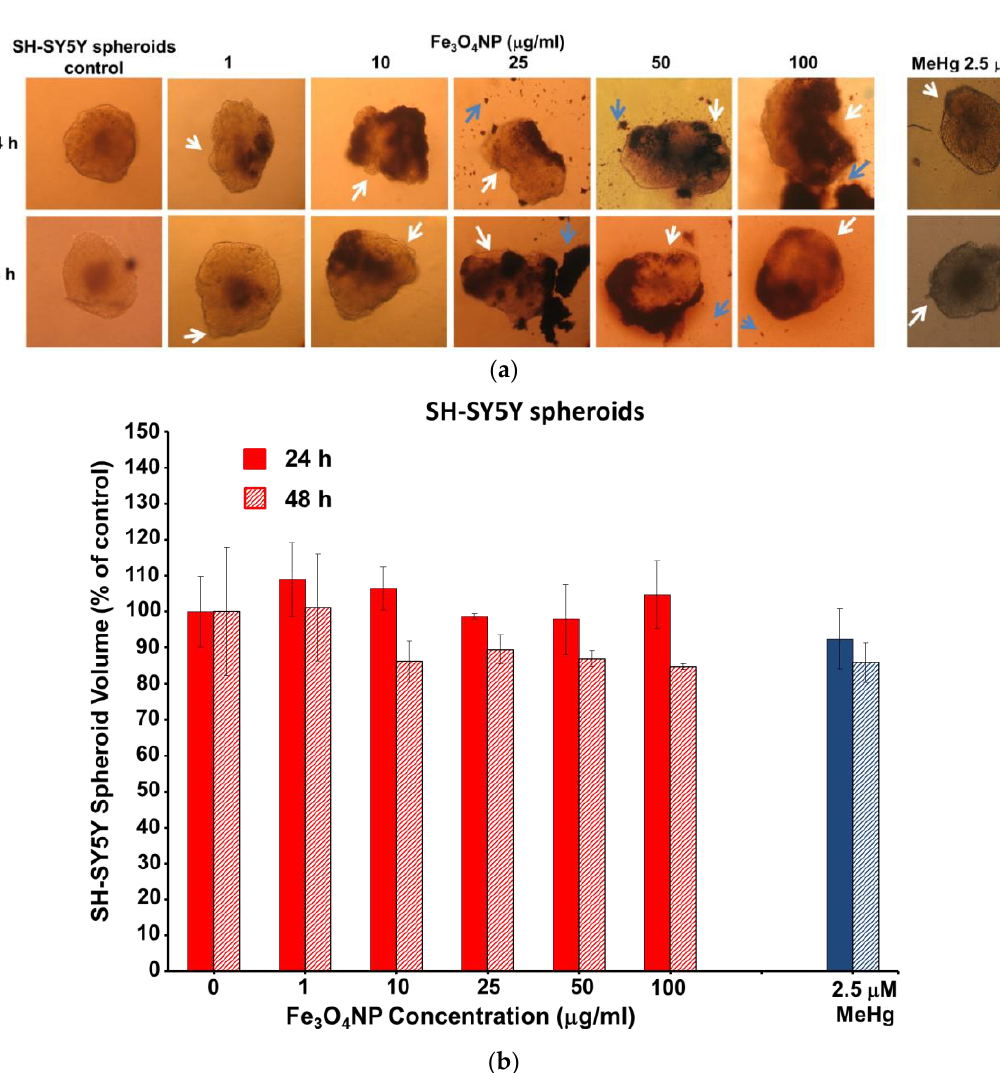
Figure 5. Morphology and volume of neuronal spheroids after short-term treatment with Fe 3 O 4 NPs: ( a ) Bright-field images of SH-SY5Y spheroids, washed with PBS, exposed to increasing concentrations of Fe 3 O 4 NPs after 24 and 48 h. White arrows indicate spheroid disaggregation and blue arrows indicate outside sediments of Fe 3 O 4 NPs. Scale bar: 100 μm; ( b ) Bar chart showing the volume growth (% of control) of SH-SY5Y spheroids formed after 24 and 48 h, with error bars representing standard deviation of the mean ( n = 4).